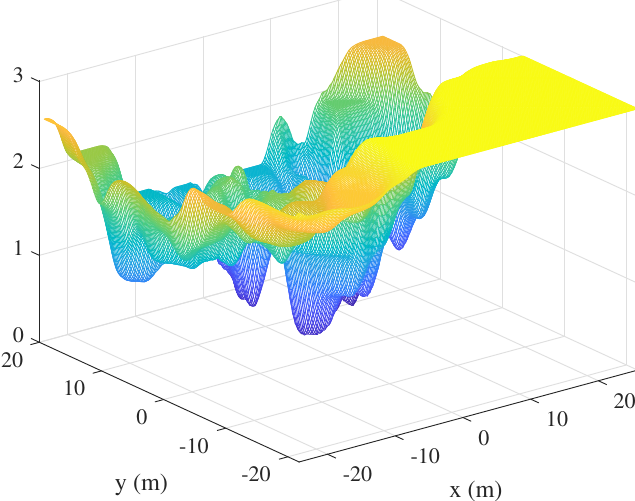
Figure 5. The visible landmark uncertainty (VLU)